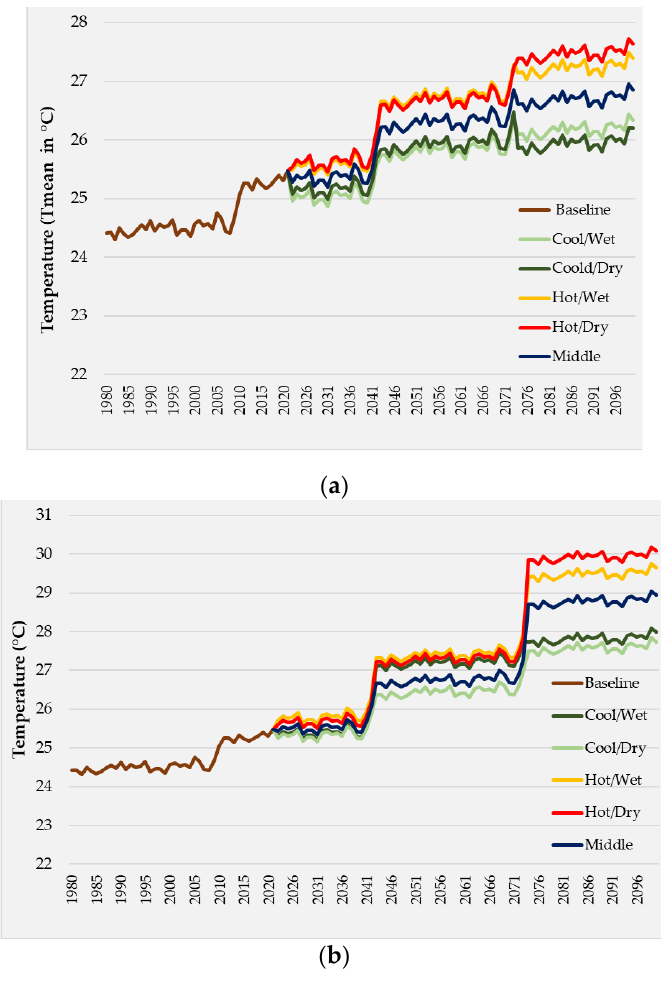
Figure 2. Trends in temperature for future climate for RCP 4.5 ( a ) and RCP 8.5 ( b ) .